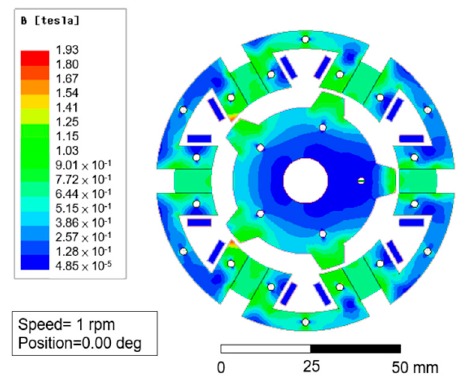
Figure 7. The magnetic flux density of 6 / 5 FSPM structure.